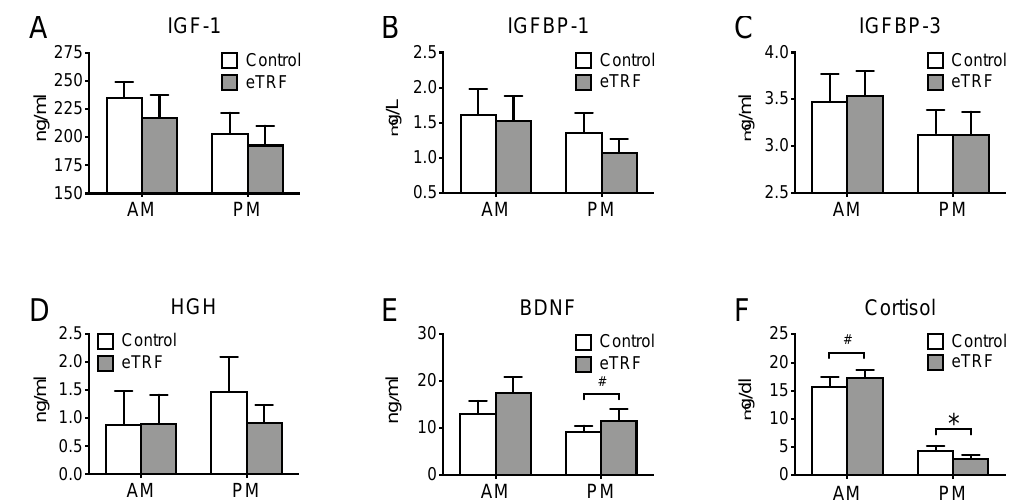
Figure 5. Hormones. Relative to the control arm, early time-restricted feeding (eTRF) tended to increase ( F ) cortisol levels in the morning (AM). In the evening, it lowered ( F ) cortisol and tended to increase ( E ) brain-derived neurotrophic factor (BDNF). The hormones ( A ) insulin-like growth factor (IGF-1), ( B ) IGF-binding protein 1 (IGFBP-1), ( C ) IGF-binding protein 3 (IGFBP-3), and ( D ) human growth hormone (HGH) were not significantly different between arms. * p < 0.05 , # p < 0.10 .